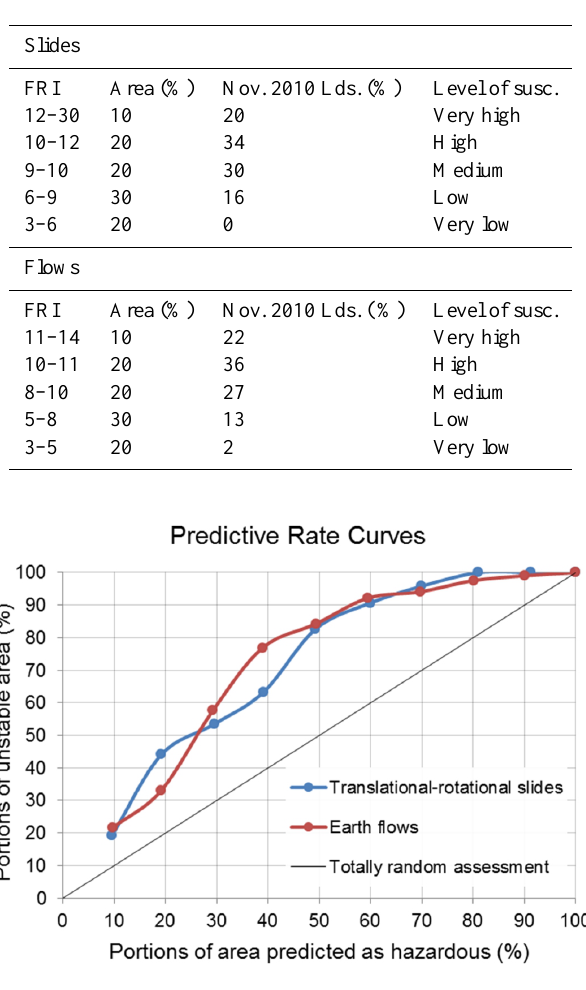
Figure 6. Predictive rate curves showing how the adopted model fits the instabilities triggered by the November 2010 rainfall